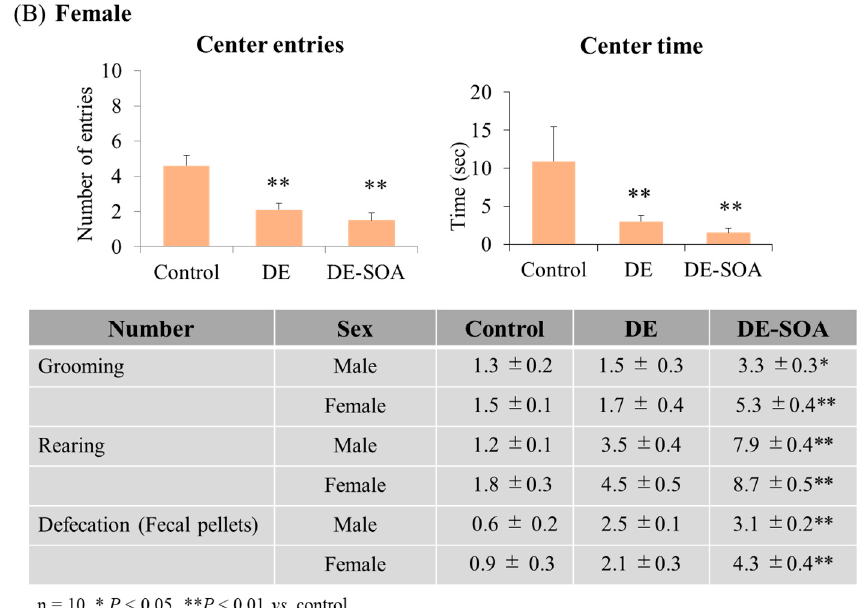
Figure 2. Open field test. Number of entries to the center and time stay in the center in 10-week-old ( A ) male and ( B ) female rats of the control and the DE- or DE-SOA-exposed groups ( n = 10, ** p < 0.01, * p < 0.05 vs. control). Table shows the number of grooming, rearing and defecation (fecal pellets) during open field test.